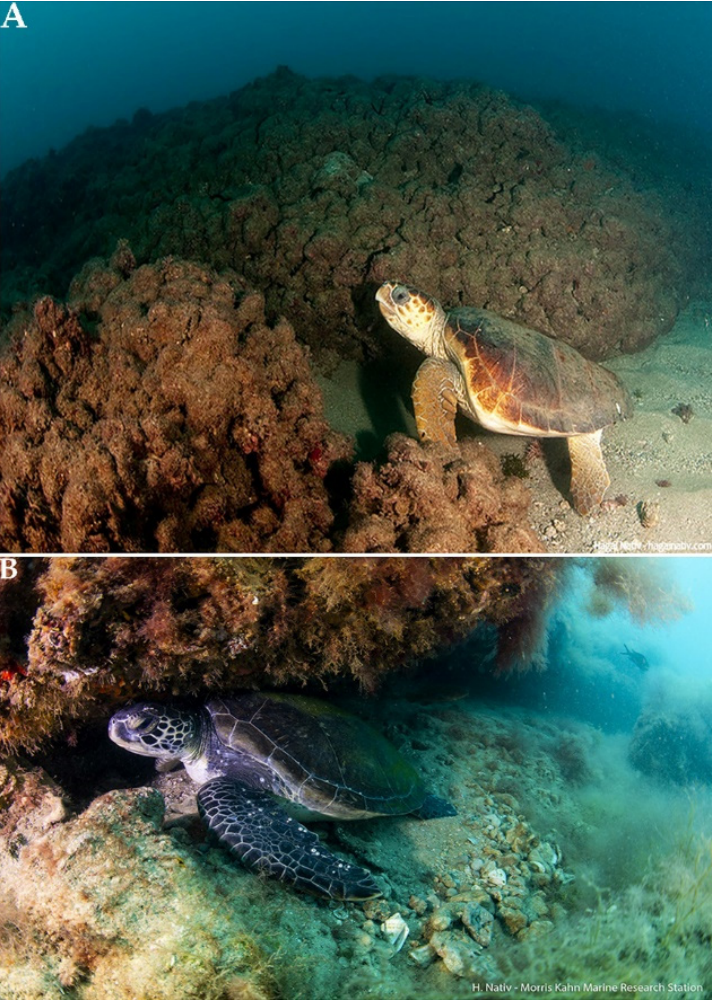
Figure 8. Loggerhead ( Caretta caretta ) ( A ) and green ( Chelonia mydas ) ( B ) sea turtles off the Mediter- ranean coast of Israel (photograph by Hagai